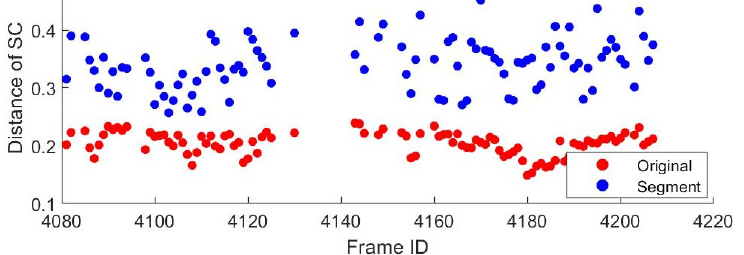
Figure 8. Comparison of false loop pairs’ similarity scores before and after